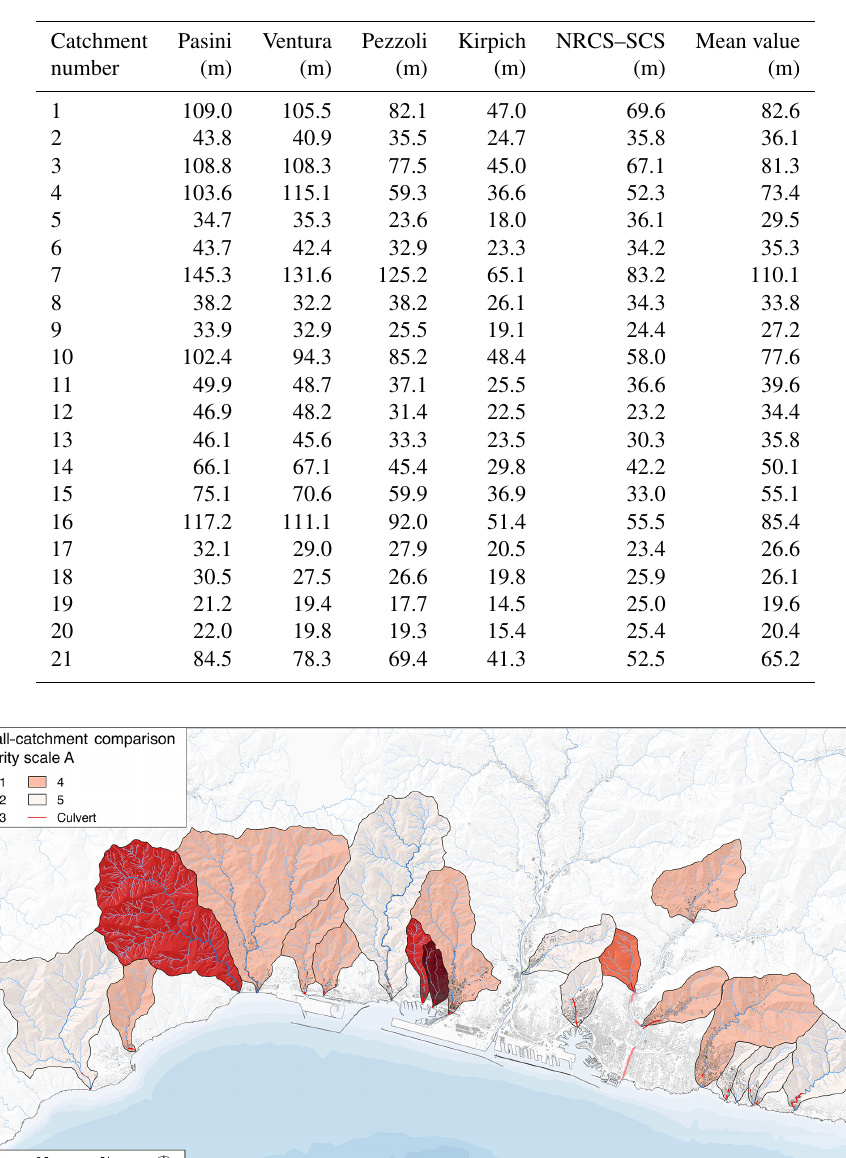
Table 6. Time of concentration for the studied catchments: five methodologies have been used and the mean value has been chosen as representative in Table 4.